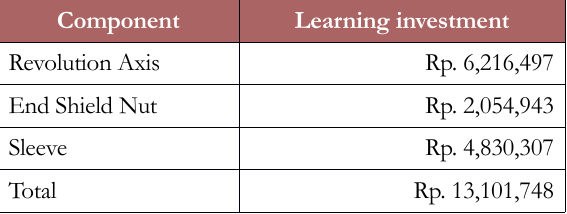
Table 18. Learning investment in supplier side